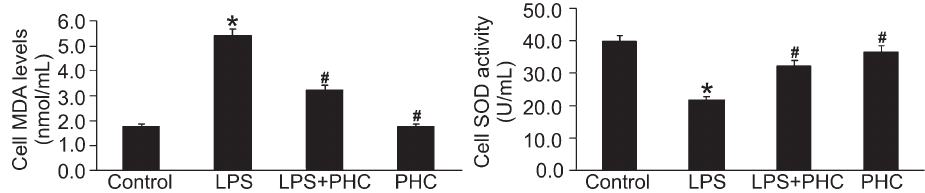
Figure 6. Inhibition of lipopolysaccharide (LPS)-induced malondialdehyde (MDA) increase and superoxide dismutase (SOD) decrease by penehyclidine hydrochloride (PHC) (n=5). Human pulmonary microvascular endothelial cells were pre-incubated with PHC for 1 h and treated with 0.1 m g/mL LPS for 1 h. LPS treatment significantly induced MDA increase and SOD decrease, which was attenuated by PHC pretreatment. In addition, PHC alone had no effect on basal MDA and SOD levels. Data are reported as means±SD. *P , 0.01, compared to control; # P , 0.05, compared to LPS treatment